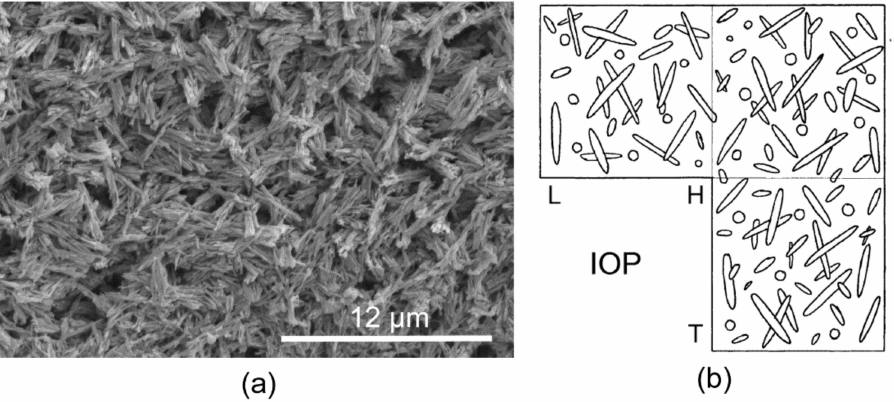
Figure 2. IOP structure in the tube of Apomatus globifer . ( a ) Transverse section, polished and etched with acetic acid. ( b ) Schematic line drawing of the IOP